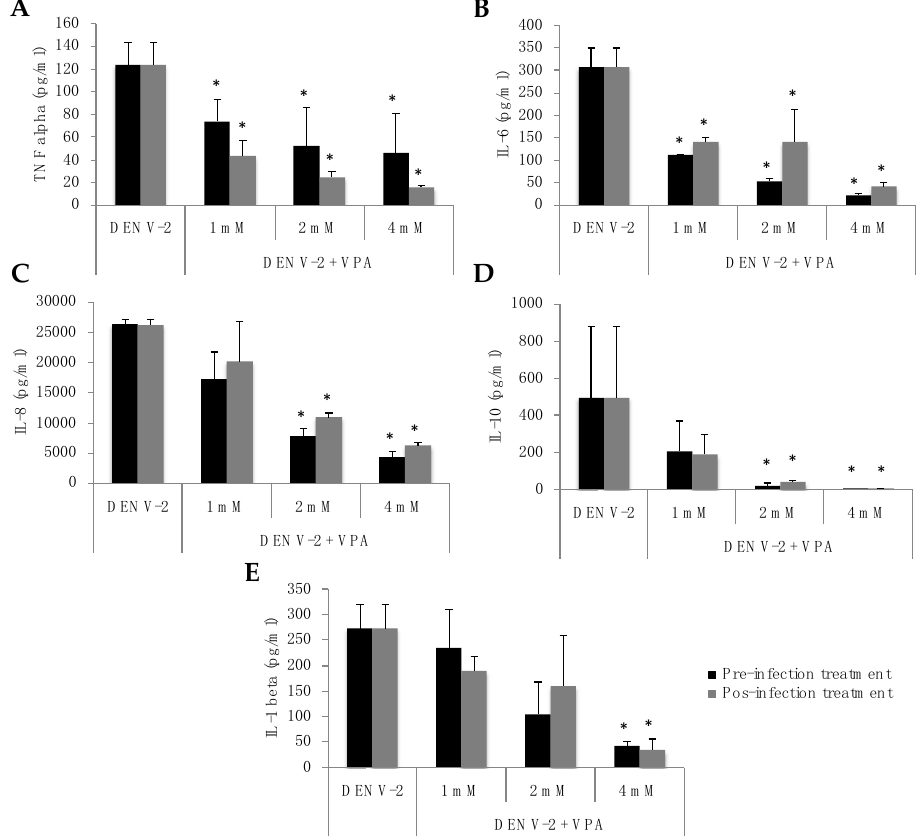
Figure 3. VPA treatment of monocyte ‐ derived macrophages (MDMs) infected with DENV2 induced a significant decrease in inflammatory cytokine production. MDMs were infected with DENV ‐ 2 at a multiplicity of infection (MOI) of 1 and treated with VPA (1, 2, or 4 mM) three hours before or after infection. At 24 h post ‐ infection, the supernatants were used to quantify the production of TNF ‐ alpha ( A ); IL ‐ 6 ( B ); IL ‐ 8 ( C ); IL ‐ 10 ( D ) and IL ‐ 1beta ( E ). Error bars represent the mean ± SEM of three independent experiments. * p values were calculated using the non ‐ parametric two ‐ tailed Mann ‐ Whitney test. A p value < 0.05 was considered significant.